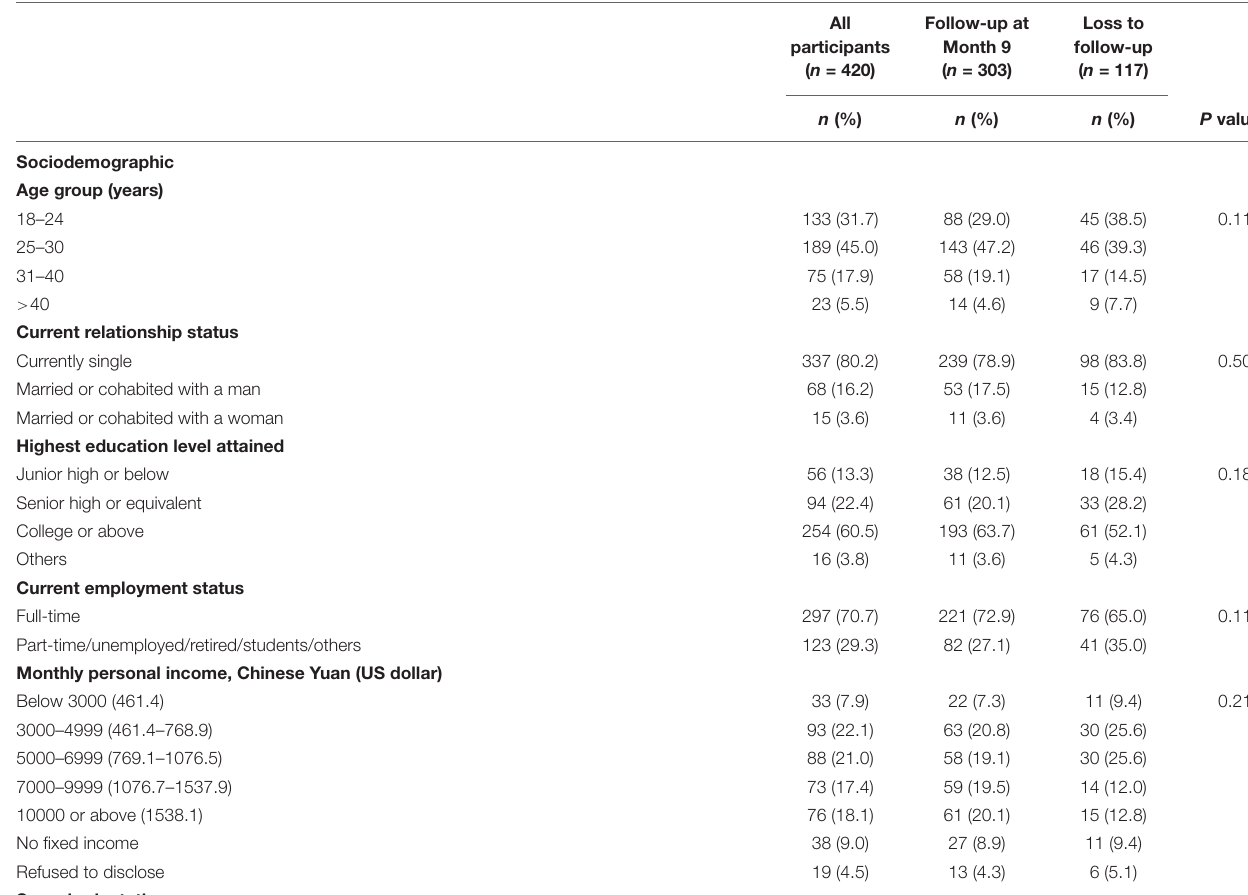
TABLE 1 | Baseline characteristics of